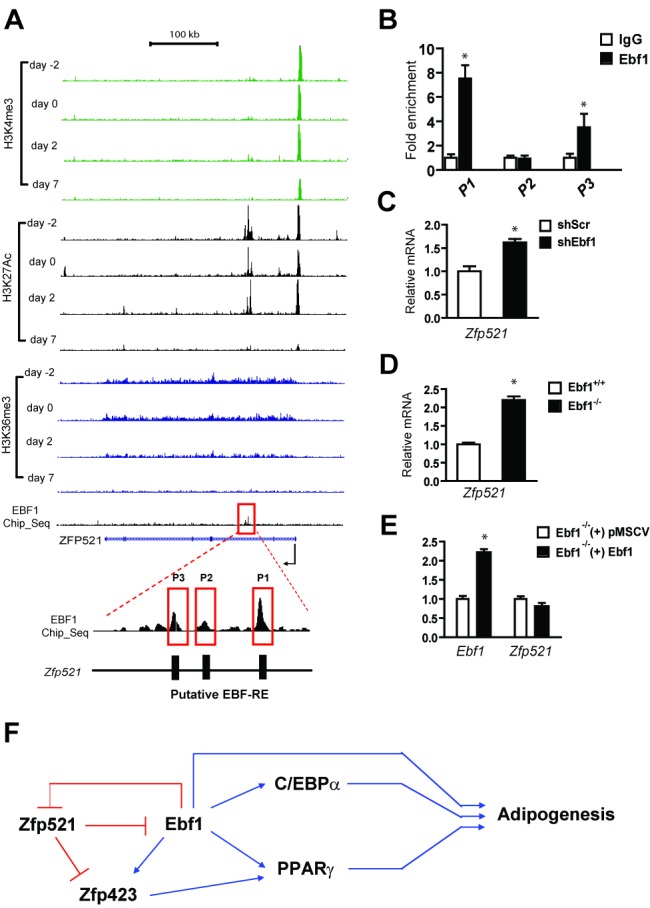
Ebf1 suppresses Zfp521 expression via an intronic binding site.(A) ChIP-Seq tracks corresponding to the Zfp521 locus are shown for three histone marks: H3K4me3 (green), H3K27Ac (black), and H3K36me3 (blue) at four time-points during 3T3-L1 adipogenesis. A cluster of Ebf1 peaks highlighted in the red box contains three putative Ebf1-responsive elements (EBF-RE). (B) ChIP-PCR analysis was performed with antibody against IgG or Ebf1 in 3T3-L1 preadipocytes. Immunoprecipitated DNA was amplified with Q-PCR using primers designed for the three putative EBF-REs shown in (A). (C) Zfp521 mRNA expression was measured in 3T3-L1 preadipocytes transduced with shScr or shEbf1. (D) Zfp521 mRNA expression was measured in confluent Ebf1+/+ and Ebf1−/− MEFs. (E) Ebf1 and Zfp521 mRNA expression was measured in Ebf1+/+ and Ebf1−/− MEFs transduced with Ebf1 or empty vector. Data presented as mean ± SD, n = 3, *p<0.05. (F) A proposed model for the transcriptional cascade involving Zfp521, Ebf1, and Zfp423.